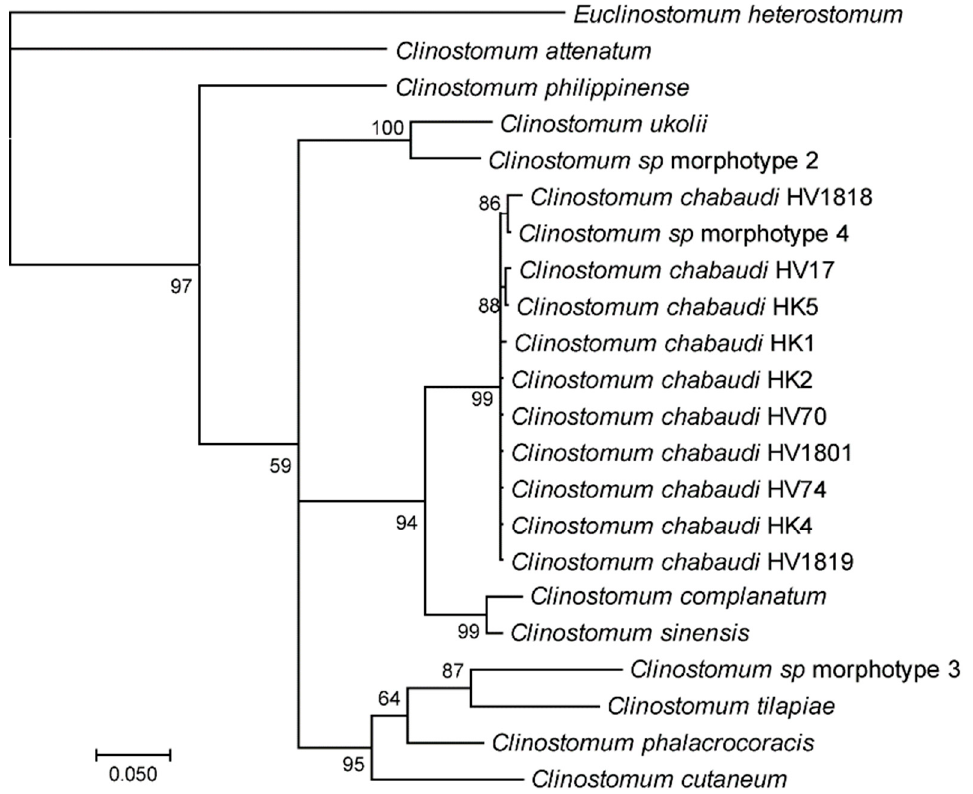
Figure 3. Molecular identification of Clinostomum chabaudi based on COX1 sequences and phylogenetic relationships among the palearctic Clinostomum species by Bayesian inference. The South American Clinostomum attenuatum and Euclinostomum heterostomum are used as outgroups (Table 2). Posterior probability values are indicated. Scale bar gives substitutions per site. Table 3. Morphometric features of Clinostomum chabaudi metacercariae collected from different host species. Data are given as the minimum-maximum range, arithmetic mean and corresponding standard deviation. Abbreviations: BL = Body Length, BW = Body Width, OSL = Oral Sucker length, OSW = Oral Sucker Width, VSL = Ventral Sucker length, VSW = Ventral Sucker width, DBS = Distance between Sucker, ATL = Anterior Testis Length, ATW = Anterior Testis Width, PTL = Posterior Testis Length, PTW = Posterior Testis Width, OL = Ovary Length, OW = Ovary Width, CPL = Cirrus Pouch Length, CPW = Cirrus Pouch Width. * measurements given as diameter; n.a. = not available.